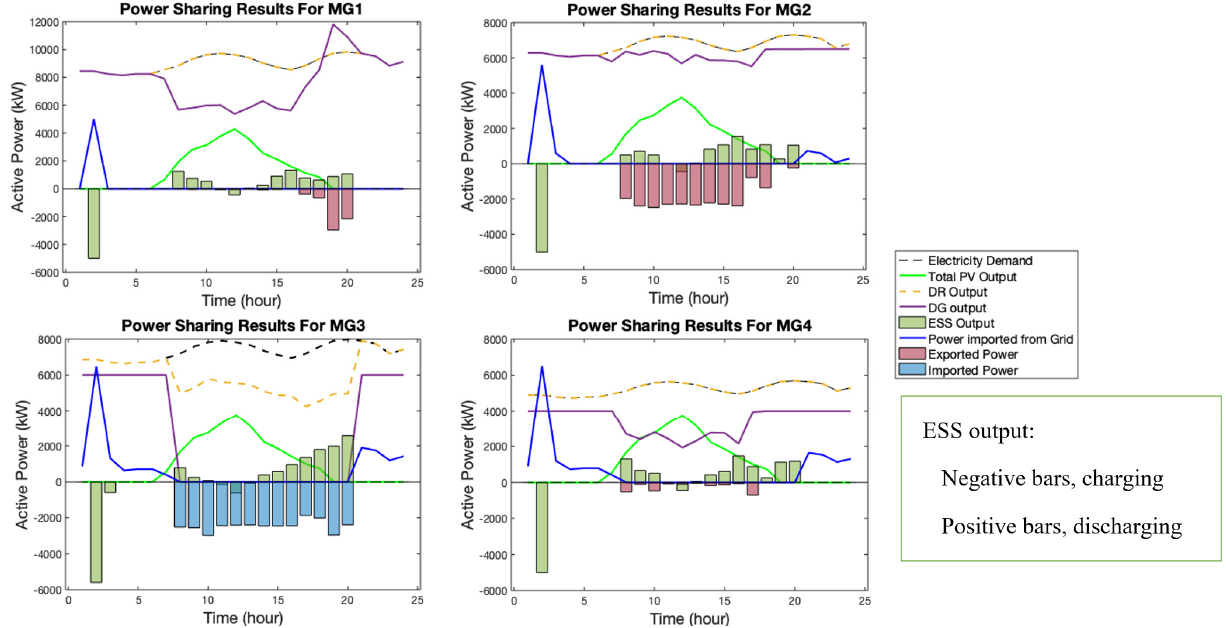
Figure 8. Interconnected MGs in off-grid mode and with power sharing.